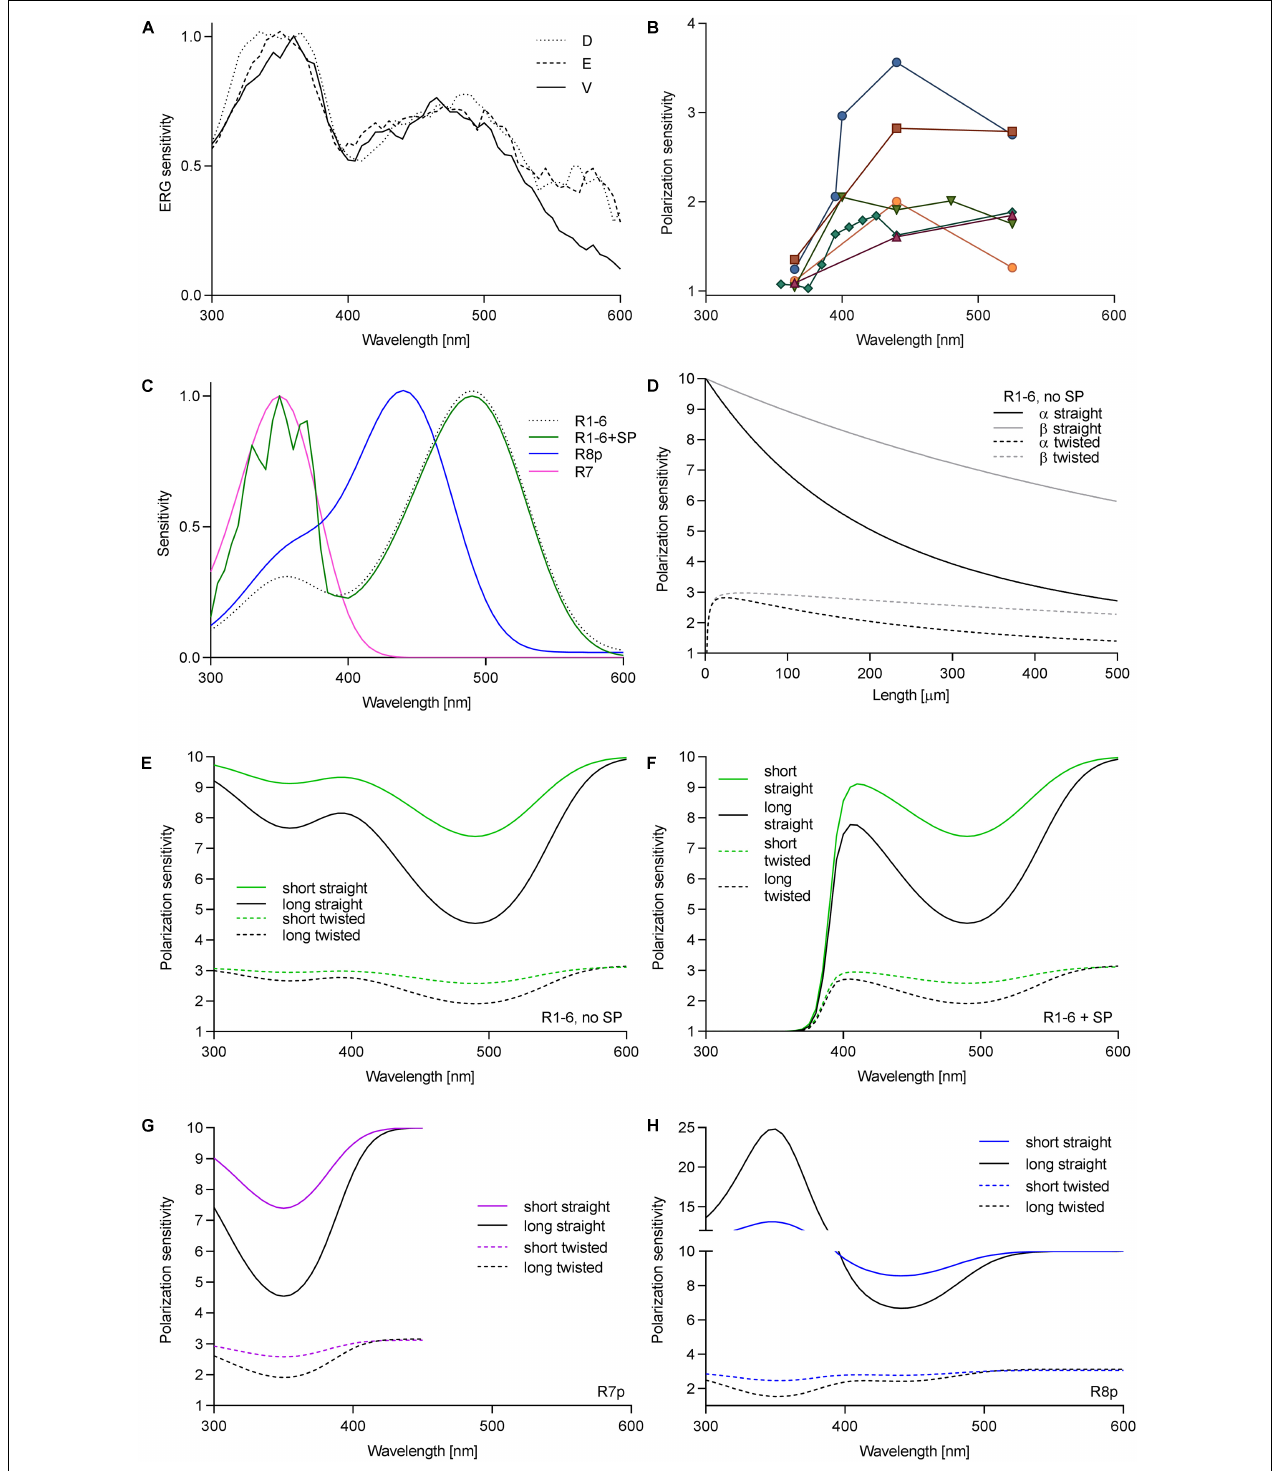
FIGURE 1 | Wavelength dependence of PS in fly photoreceptors. (A) Spectral sensitivity of Drosophila , measured via ERG in dorsal (D), equatorial (E), and ventral (V) retina. (B) PS of single Drosophila R1–6 cells as a function of wavelength; different colors represent individual cells ( N = 6). (C) Spectral sensitivities of fly photoreceptors; R1–6, Rh1 ( λ max = 486 nm), R7p, Rh4 ( λ max = 355 nm); R8p, Rh5 ( λ max = 440 nm). (D) PS of R1–6 without sensitizing pigment as a function of rhabdomere length and twist in the blue (PS α ) and in the UV (PS β ). Theoretical PS, calculated in short rhabdomeres ( l = 80 µ m), long rhabdomeres ( l = 250 µ m), with straightly aligned or twisting microvilli, in R1–6 without sensitizing pigment (E) , with sensitizing pigment (F) , R7p (G) , and R8p (H) .